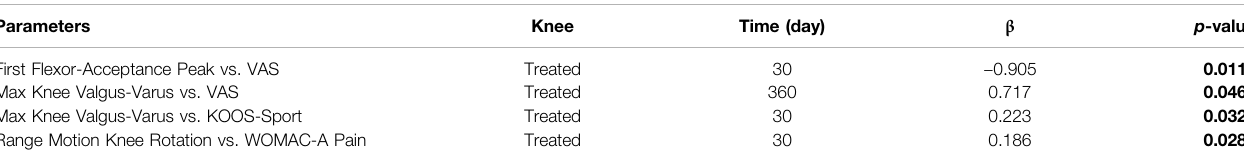
TABLE 5 | Correlation analysis. Parameters First Flexor-Acceptance Peak vs.